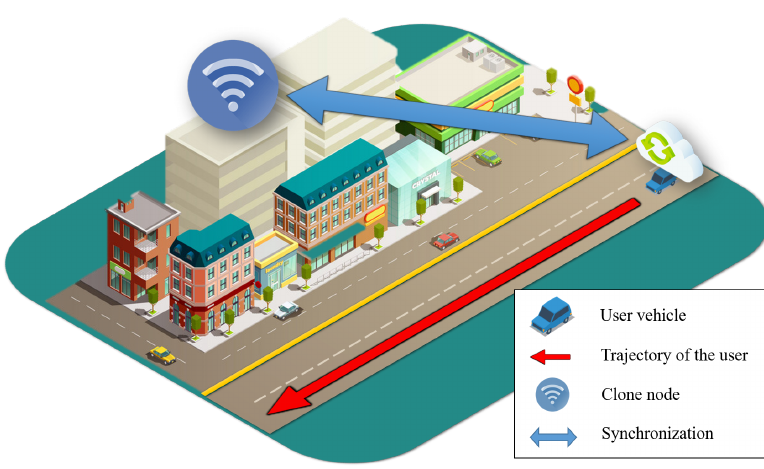
Figure 2. The packet delivery synchronization from a clone node to a user vehicle based on the packet